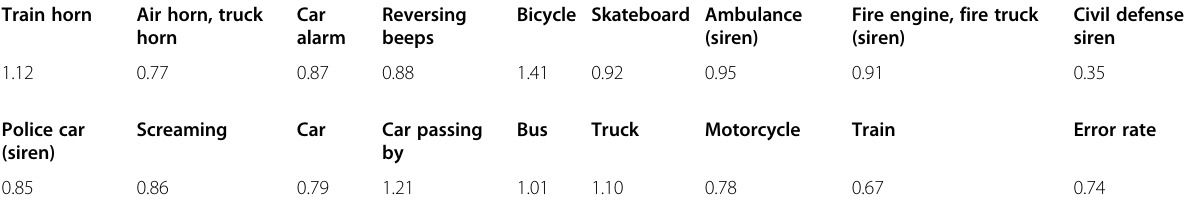
Table 9 Error rate of sound event detection subtask for each event Train